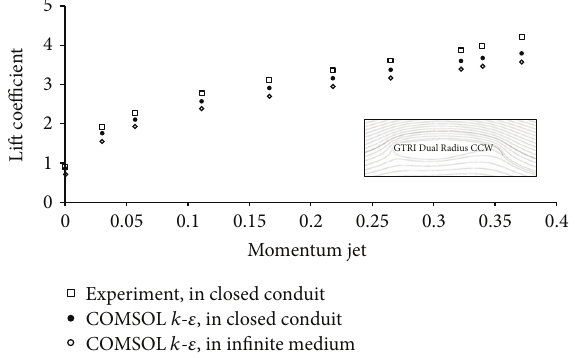
Figure 7: Comparison of lift-curve slope for GTRI Dual Radius CCW airfoil with LE blowing on CFD computation using COMSOL k - 𝜀 turbulence model and experimental values from Englar et al. [5] at Re =